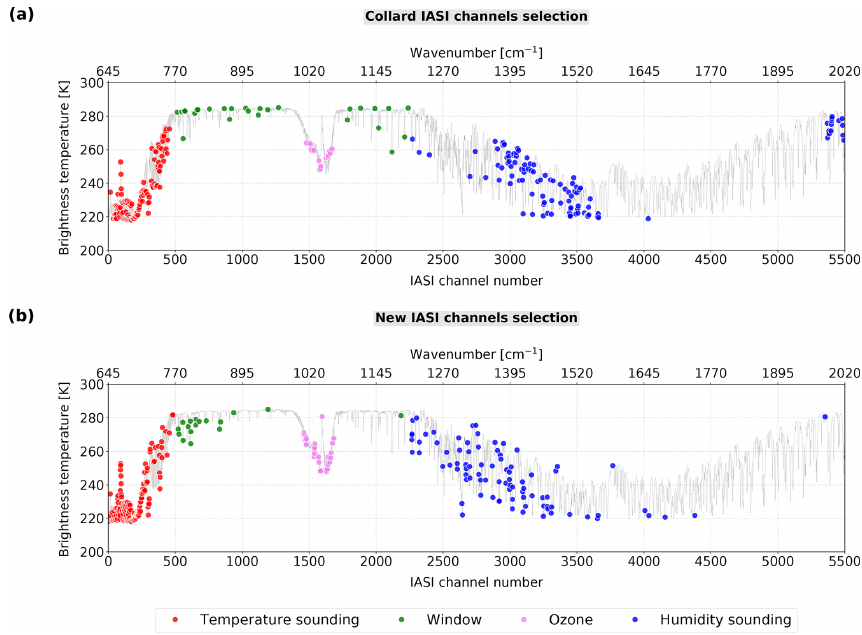
Figure 10. Comparison between the 275 channels selected by Collard (a) and the 275 new channels selected (b) on a typical IASI spectrum in brightness temperature on bands 1 and 2. The red, green, purple and blue circles represent the channels of temperature-sounding, window, ozone and humidity-sounding spectral groups,